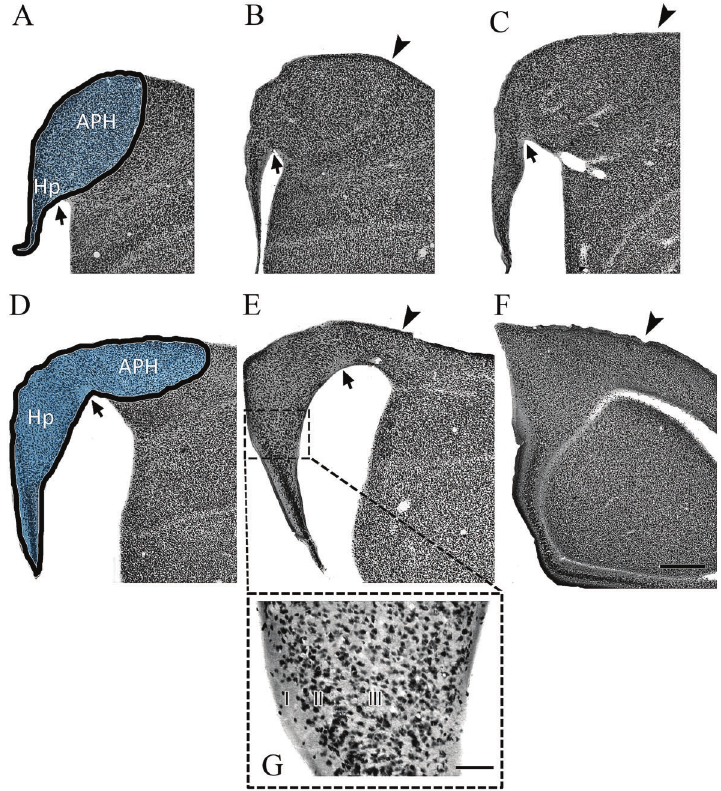
Figure 1. Hipocampal neurons of Calidris pusilla . Coronal series of NeuN-immunolabeled sections of the C. pusilla hippocampal formation. The left to right sequence is from the frontal to the occipital pole of the hippocampal formation. In the fi rst sections of the top and bottom rows, the dark line de fi nes the area of interest. The arrow- heads indicate limits of the area of interest. The arrows indicate the paraventricular sulcus. APH: parahippocampal area; Hp: hippocampus. Scale bar: 500 m m. Photomicrography with 10 (cid:2) mag- ni fi cation of the ventral region of the dorsomedial hippocampus of C. pusilla shows three distinct layers: layer I contains a few scattered neurons; layer II is formed by two or three rows of densely packed neuronal cell bodies; layer III